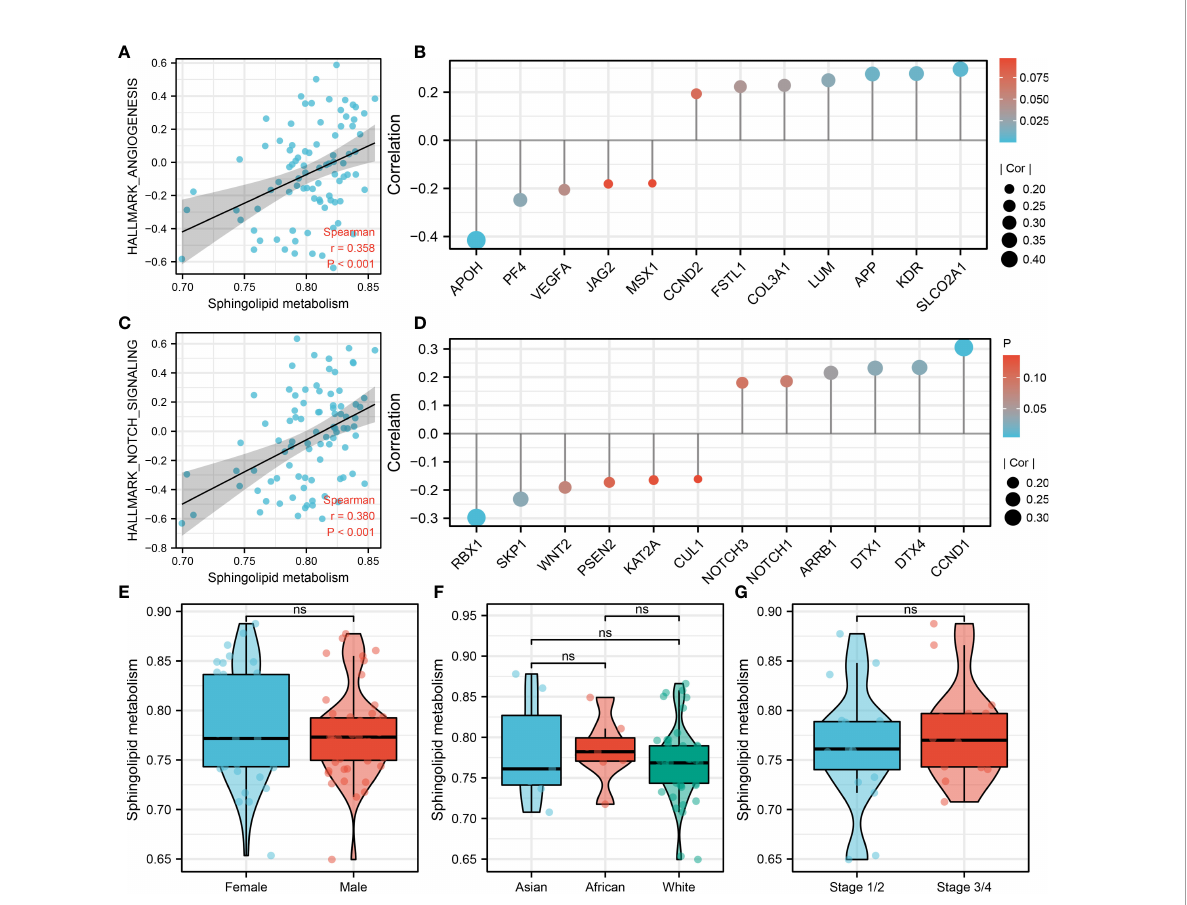
FIGURE 3 Sphingolipid metabolism was positively correlated with Notch signaling and angiogenesis Notes: (A) : Sphingolipid metabolism was positively correlated with angiogenesis; (B) : The association between the genes involved in angiogenesis and sphingolipid metabolism activity; (C) : Sphingolipid metabolism was positively correlated with Notch signaling; (D) : The association between the genes involved in the Notch signaling and sphingolipid metabolism activity; (E) : The sphingolipid metabolism difference in male and female patients; (F) : The sphingolipid metabolism difference in Asian, African and White patients; (G) : The sphingolipid metabolism difference in Stage 1/II and Stage III/IV patients. ns, P <